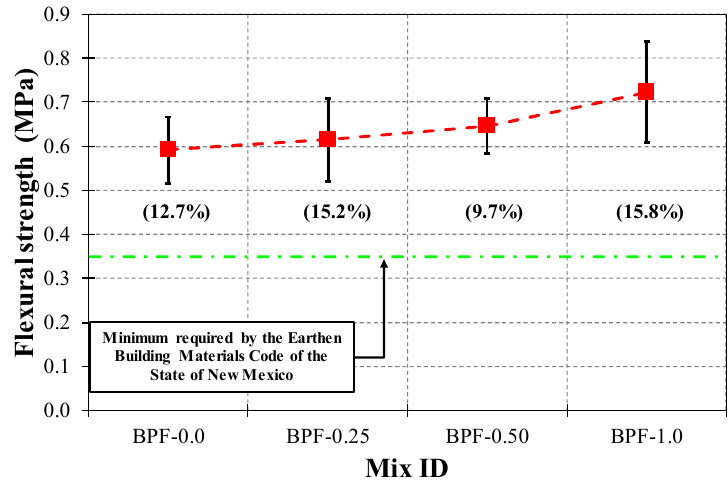
Table 6. 5% significance level ANOVA tests for the compressive strength of earthen mixes at 28 days.